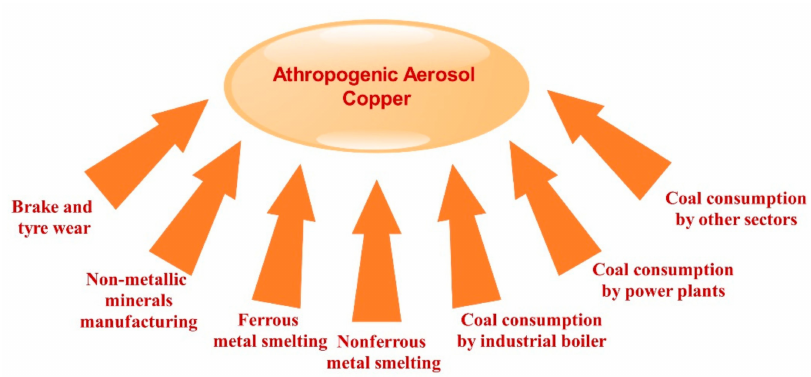
Figure 1. Anthropogenic sources of aerosol copper (Cu) in China (Data quoted from Tian et al.